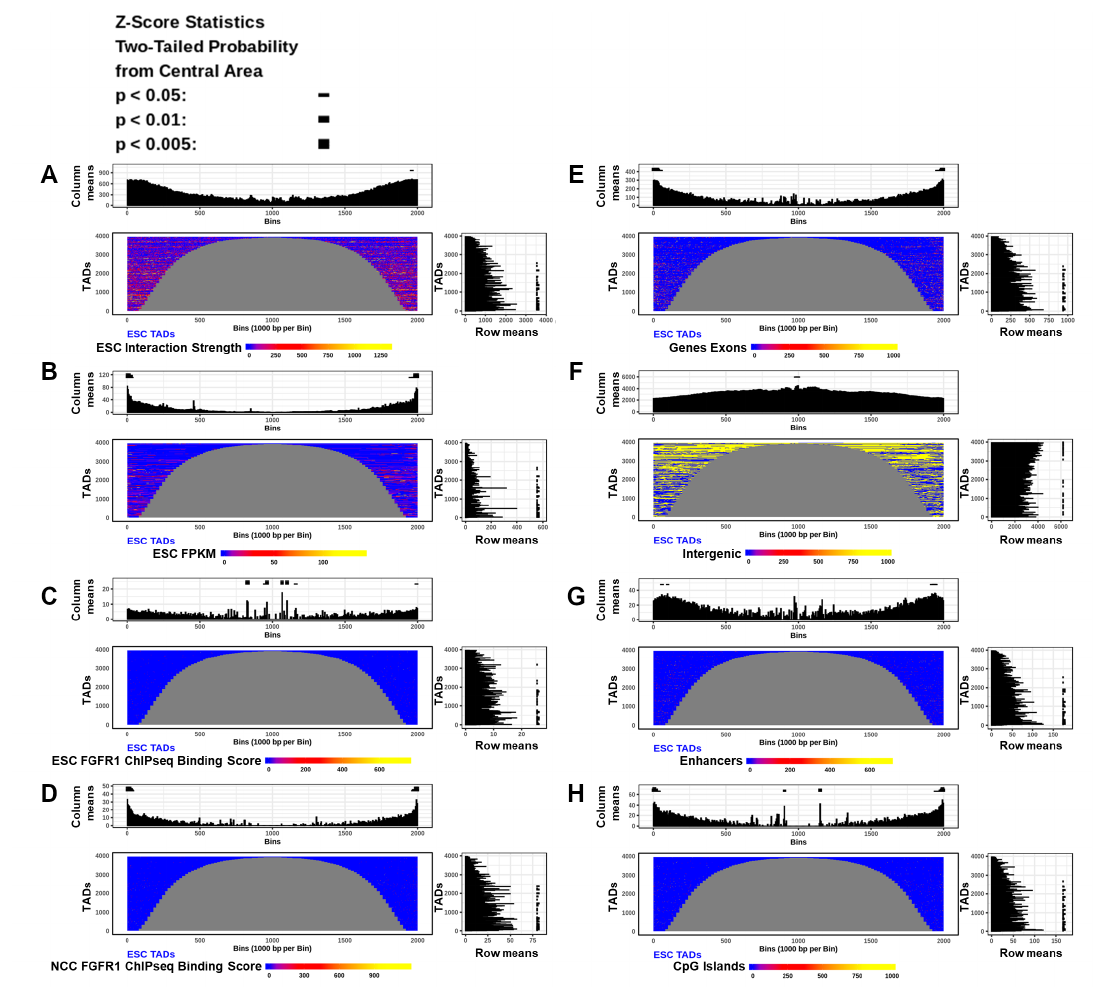
Figure 5. Interaction strength correlates with gene coding, regulatory features, and nFGFR1 binding in both ESC and NCC TADs. ( A – H ) All TADs in ESC (NCC in Figure S6) split in half and aligned by their left and right borders (NCBI Figure 3. Downregulated TADs express stage specific genes and are reorganized during ESC to NCC — directionality). Heatmaps show features enrichments in each TAD. Top and right panels to each heatmap show average differentiation. At interacting (q<0.001) upregulated and downregulated anchor-anchor midpoints: (A) — location (column means—5 kb bins) and size (row means—5 TAD bins) dependent feature enrichments across all TADs. Differential gene expression. (B) TAD overlap. (C) Directionality Index. (D) Gene Ontology Category Z-Score statistics indicate bins which are outside the mean of all bins p < 0.05 — Enrichment. Two-way ANOVA Tukey Method: ESC versus NCC for each location shown, p<1e-2 p<1e-4 ; p<1e-6 ; p<1e-8 ; p<1e-10 . At TAD borders aligned left and right based on regulated gene directionality (adjusted p<0.05): (E) TAD reorganization. (F) Differential gene expression. (G) — Differential interaction anchor strength. (H) Differential nFGFR1 binding. (I) Differential gene coding — and regulator feature enrichment. Z-Score statistics indicate bins which are outside the mean of all bins — p<0.05 ; p<0.01 ; p<0.005 . (J) Differential chromatin looping. (K) Differential nFGFR1 looping.